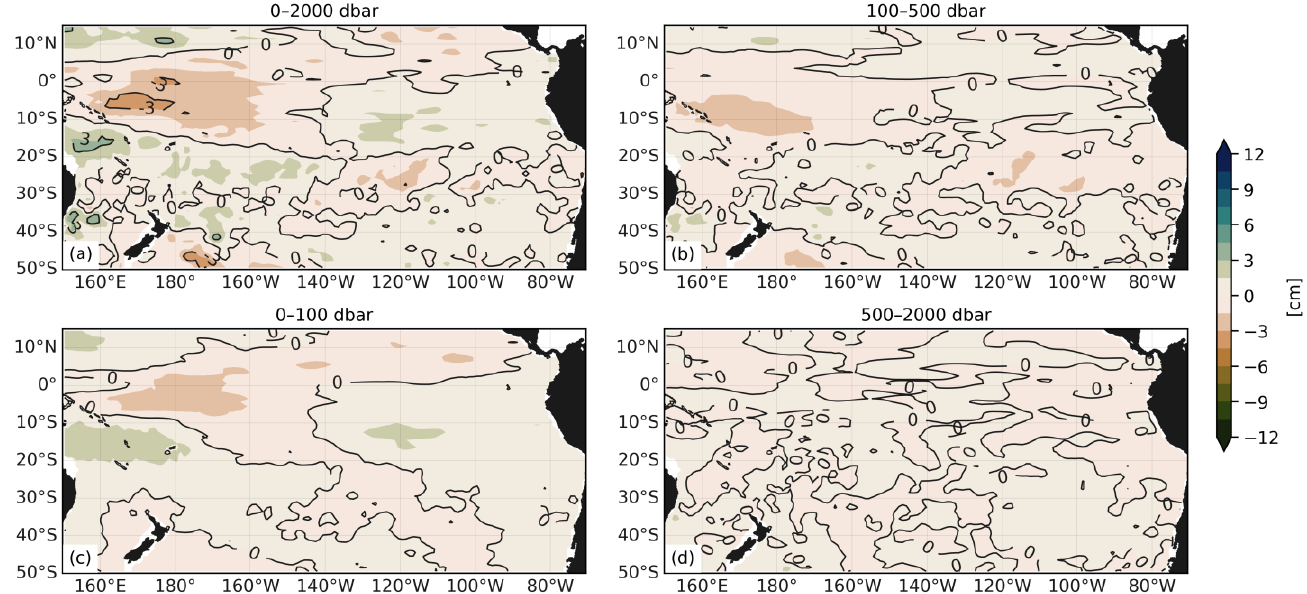
Figure 6. Differences in the Roemmich-Gilson Argo-based halosteric sea level (HSL) for 2018 minus 2016 over ( a ) 0 – 2000 dbar, ( b ) 100 – 500 dbar, ( c ) 0 – 100 dbar and ( d ) 500 – 2000 dbar. Contour lines (see inline numbers for HSL intervals) are also shown.